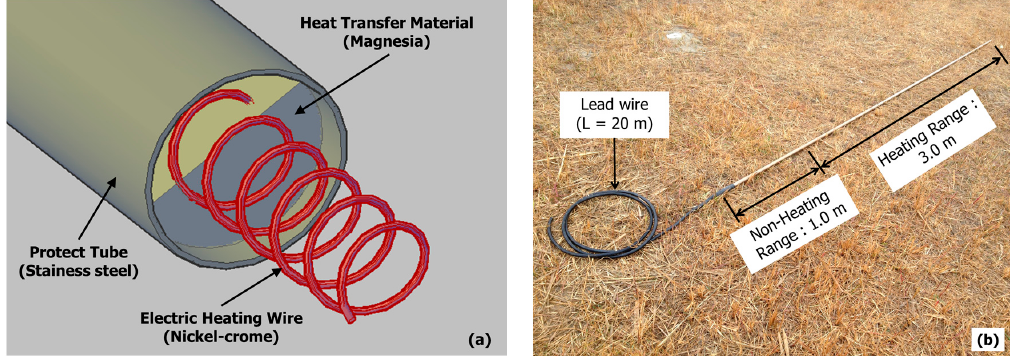
Figure 3. The electric heat pipe in the file test. ( a ) Section view; ( b ) Overall view.